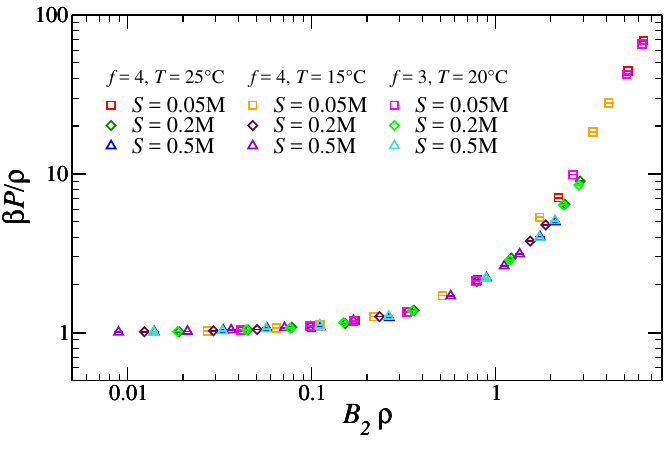
Figure 3. Reduced pressure for the reference fluid as function of the reduced density B 2 ρ , for different functionalities, salt concentrations and